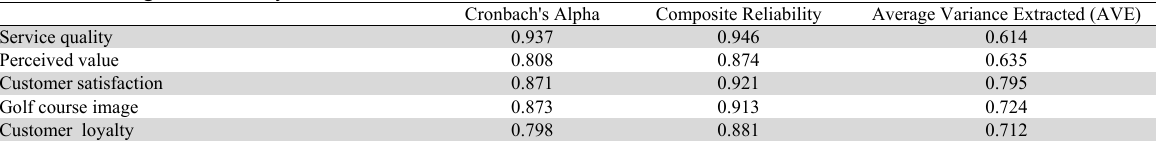
Factors affecting the reliability of data